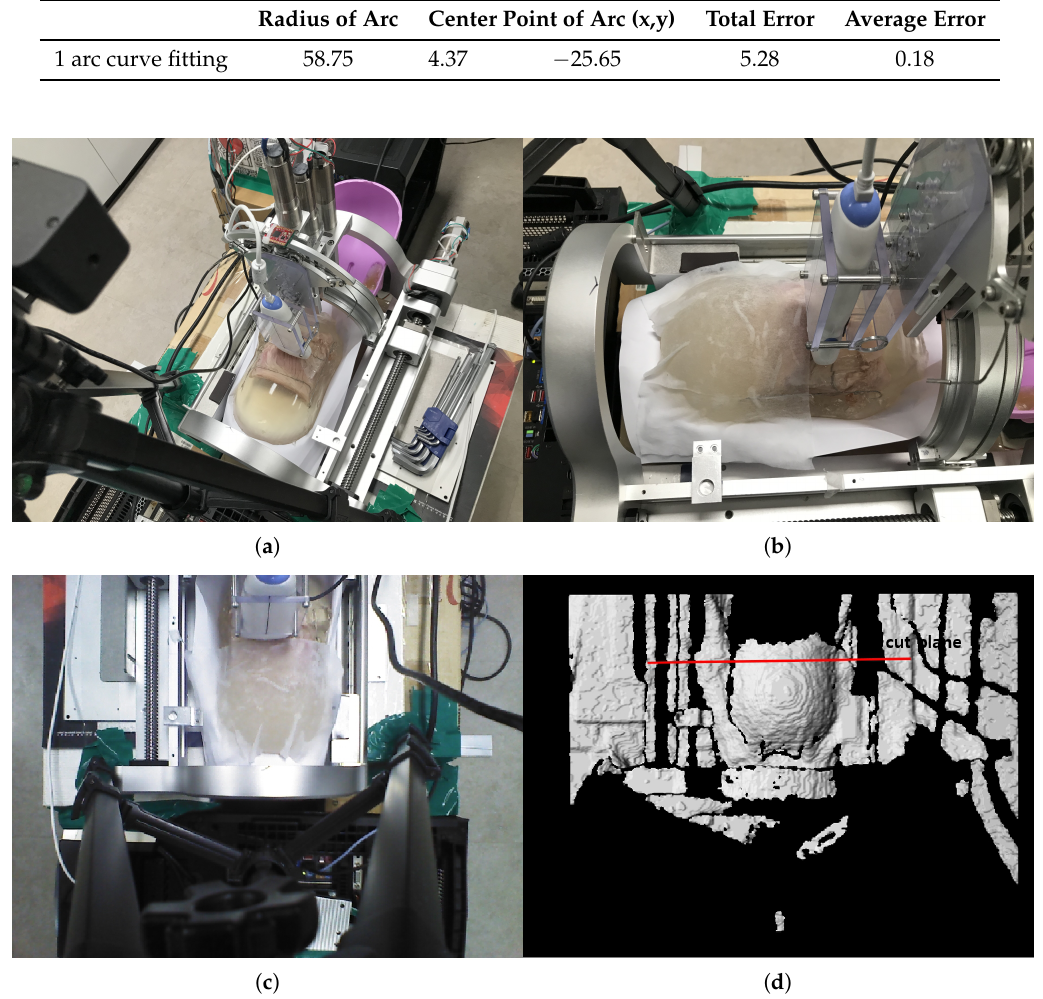
Figure 14. In-vitro test pictures. ( a ) Ham-gelatin phantom inserted in the sarcopinia detection system (Perspective view). ( b ) Ham-gelatin phantom inserted in sarcopinia detection system (Side view). ( c ) RGB data. ( d ) D data.